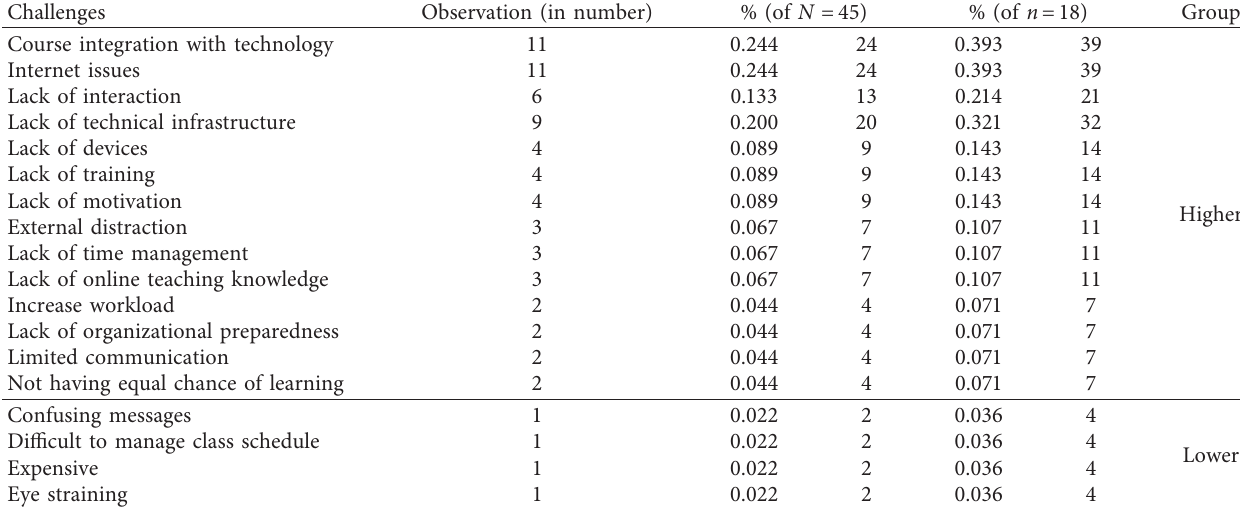
Table 6: Percentage of each challenge of online learning and their groups based on 50th quartile.